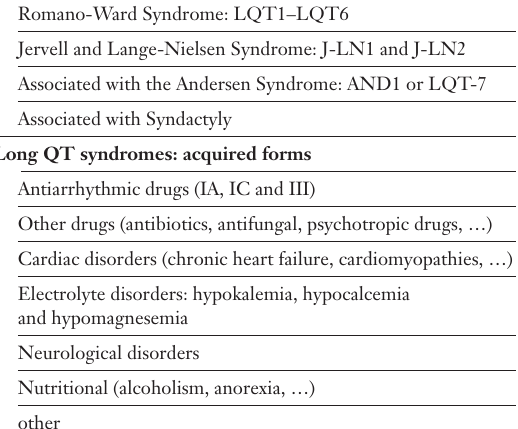
Congenital and ac- quired forms of long QT syndromes. Muta- tions in six different genes have been identified in patients and families with congenital LQTS, al- lowing the classifica- tion of LQT1–LQT6. The Andersen syn- drome (AND1 or LQT7) is a rare dis- order characterised by neurological and morphological abnor- malities in addition to a prolonged QT interval [62]. Three sporadic cases of prolonged QT inter- val associated with syndactyly have been reported [63]. How- ever, the significance of this finding may be quite low because of its